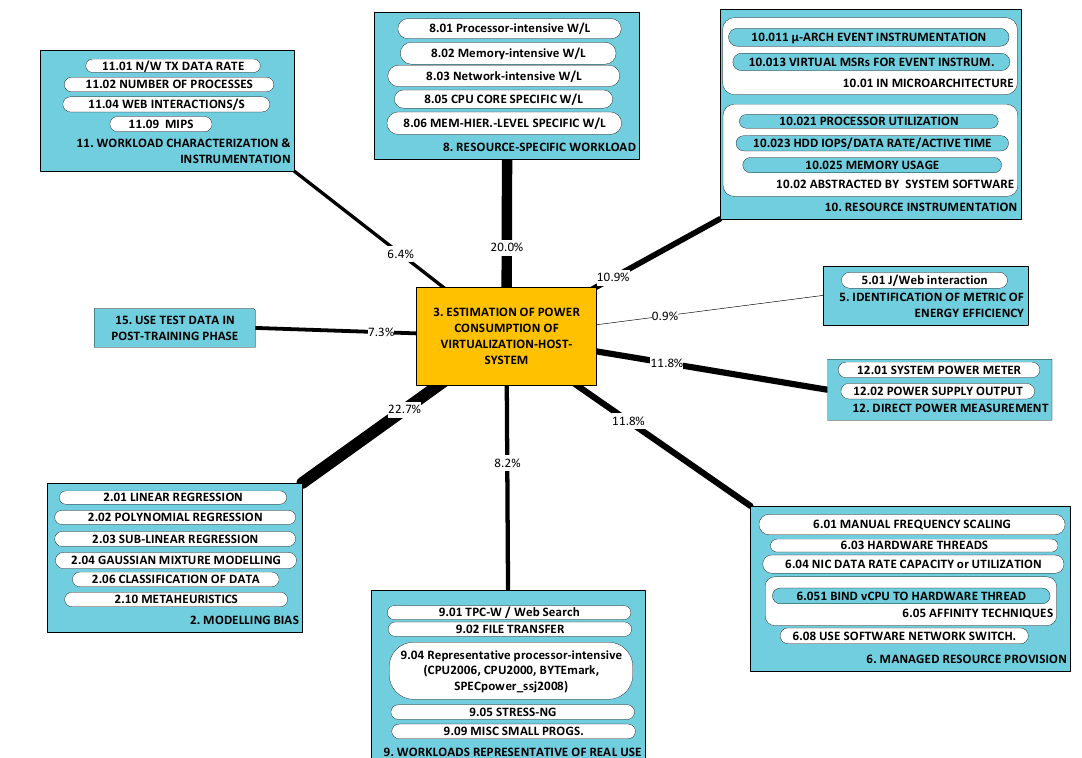
Figure 9. Approaches to solving challenges in category P3; utility metric U A thickness and as a percentage. RUs in the respective categories are the following: P3 [57–69,71]; A2 [57–64]; A5 [65]; A6 [60,66–68]; A8 [59–61,63,64,66–68,71]; A9 [57,58,60,62,65,68]; A10 [57–59,61– 64,69]; A11 [64,65,67,68,71]; A12 [57–59,61–64,67,68,71]; A15 [57,62–64].